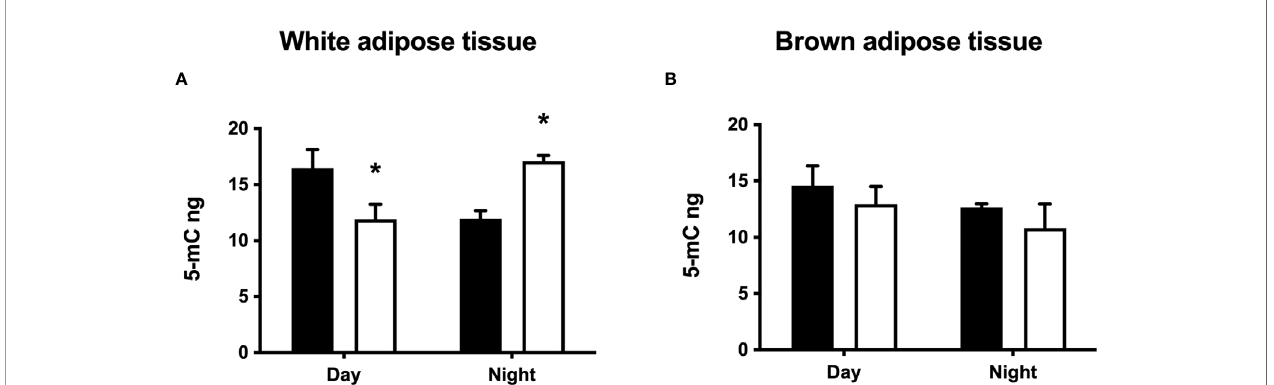
FIGURE 8 | Effects of gestational chronic phase shift of photoperiod on global genomic DNA methylation of perirenal white adipose tissue (A) and interscapular brown adipose tissue (B) from 90-day-old rats sampled at day (10:00 h) and night (22:00 h). Black bars: LD, adult rats that had been gestated under control 12:12 (LD) photoperiod. White bars: CPS, adult rats that had been gestated under chronic phase shift (CPS) photoperiod. n = 5 per group. *different from LD ( p < 0.05 pairwise comparison at each time point with Bonferroni correction).